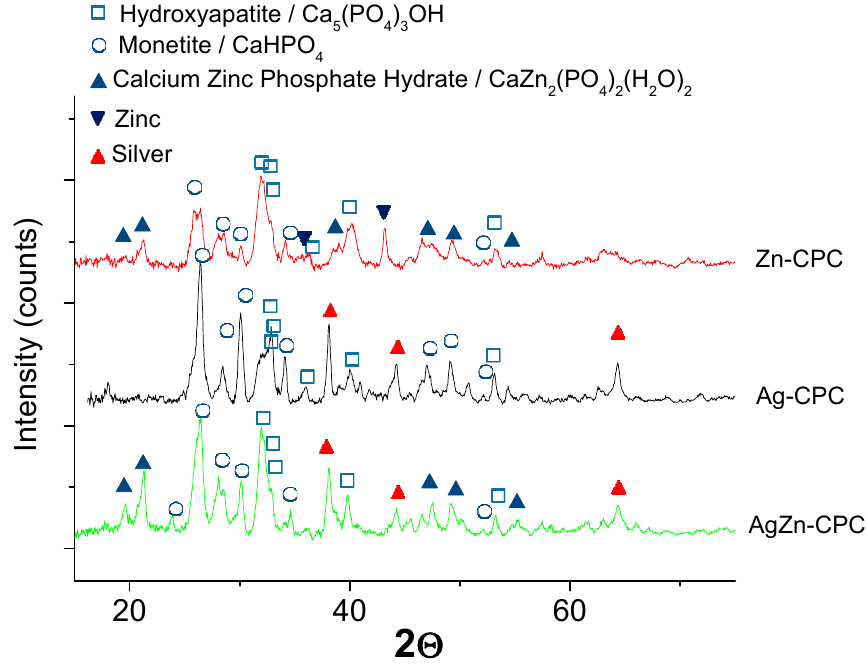
Figure 5. XRD spectra recorded on silver- and zinc-added calcium phosphate